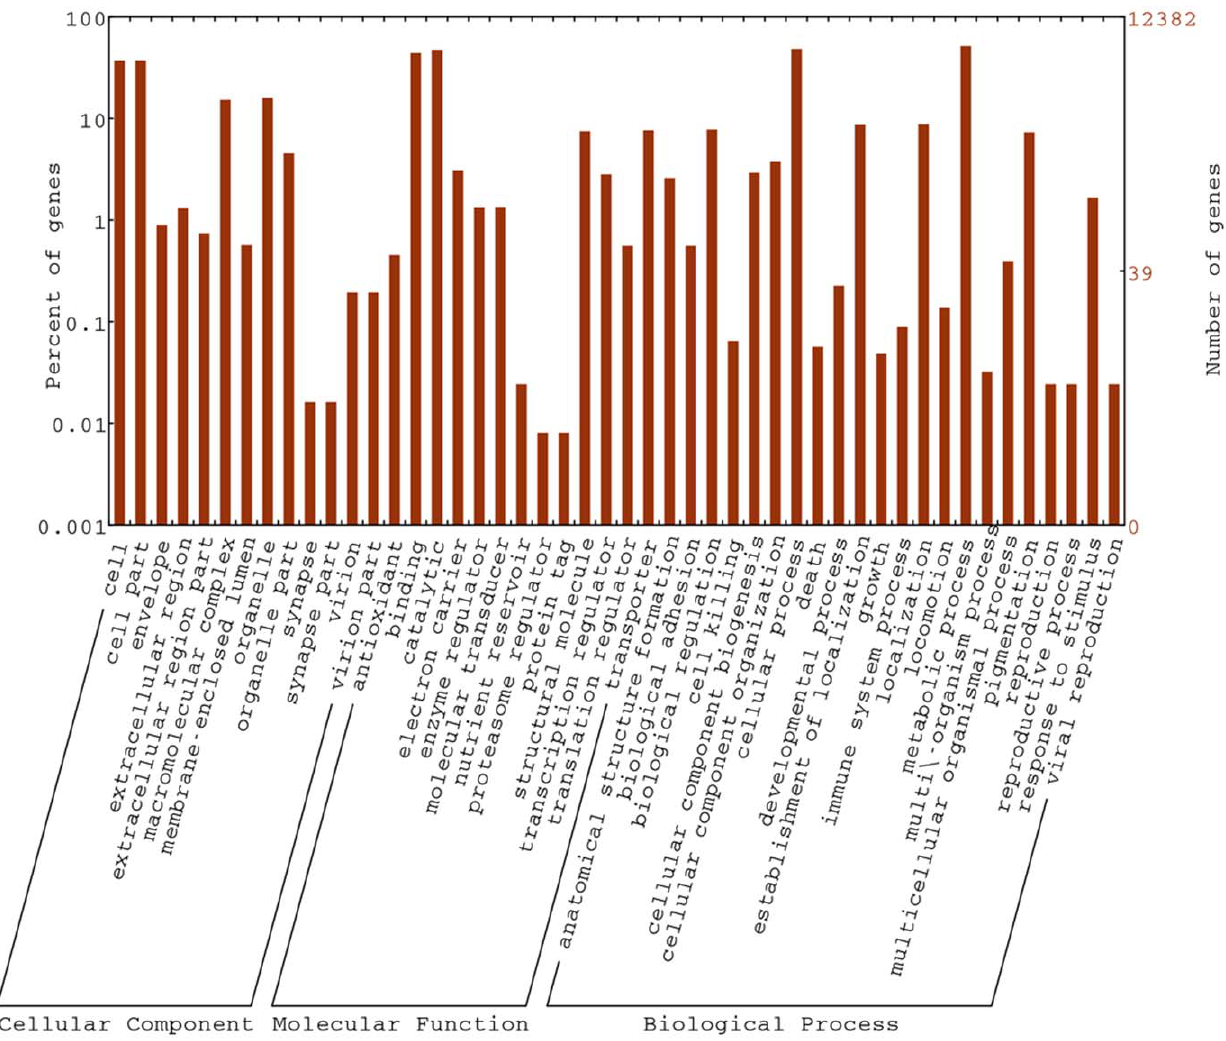
Figure 2. Gene Ontology (GO) analysis of transcriptome associated with oyster of early development. (The percentage and distribution of top-level GO-terms were portrayed in the three categories: Biological process, Cellular component and Molecular function.).